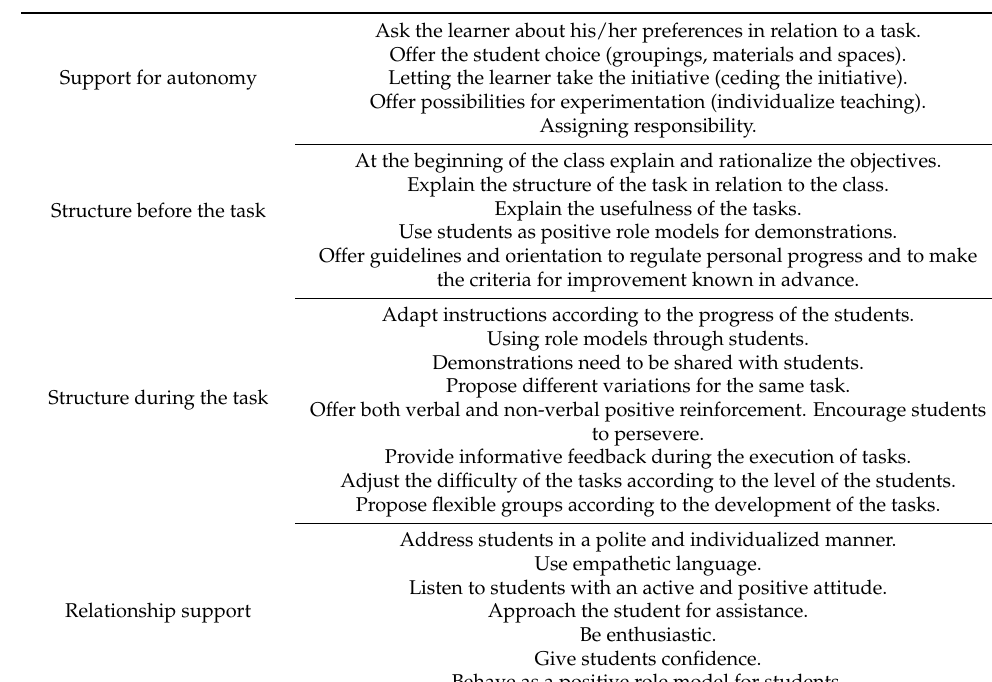
Table A1. Autonomy support